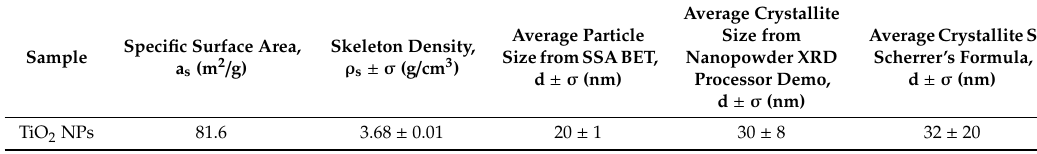
Table 3. Characteristics of the TiO 2